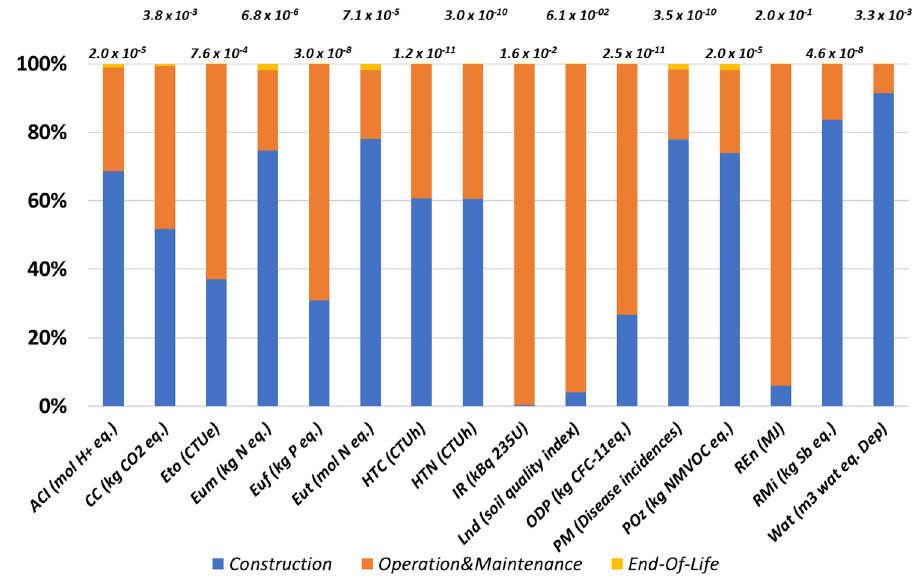
Figure 3. Percentages of contribution of main life cycle phases to the total impact in all impact categories selected. The total characterized impact for each category is reported at the top of the corresponding columns. Geothermal source type: liquid, energy conversion technology: direct heat use, load factor: 77%, annual energy output decay: <0.1%, lifetime installation: 30 years, installed capacity: 27 MW th , number of wells: 2 (GRT-1: 2580 mMD, GRT-2: 3938 m total drilled).